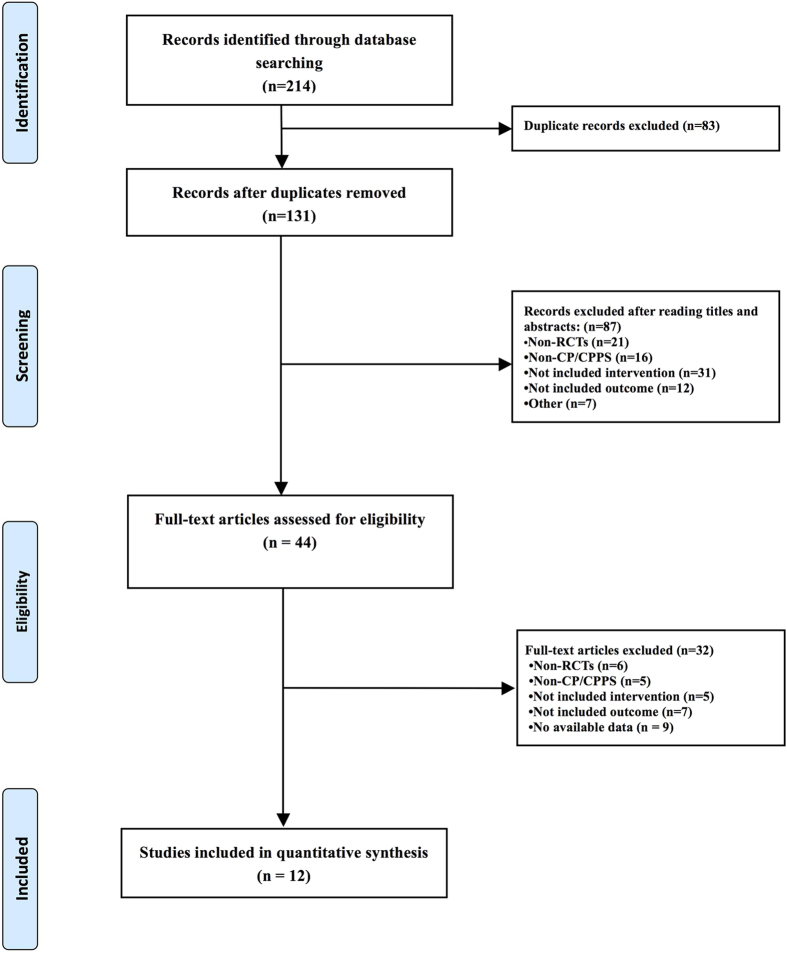
PRISMA flow chart